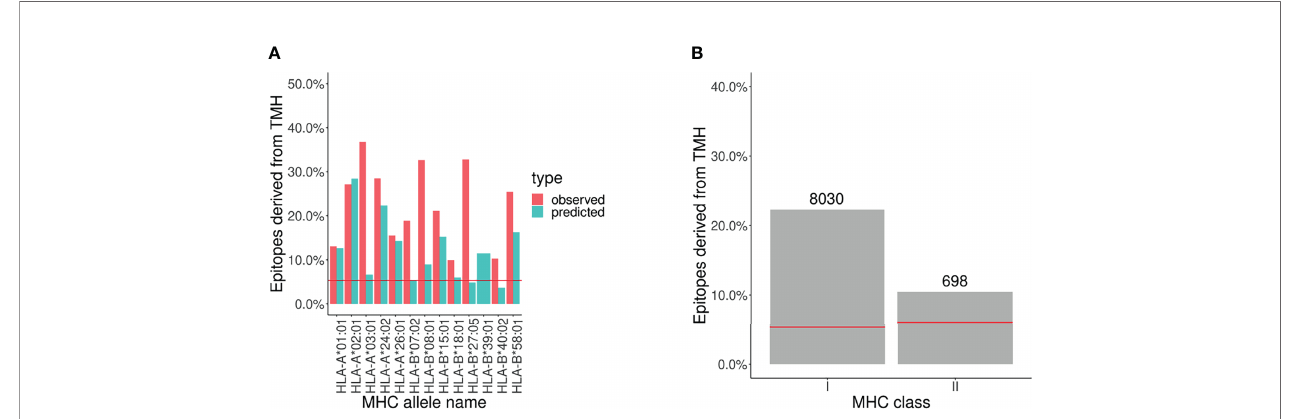
FIGURE 2 | Analysis of epitope database shows that TMH derived epitopes are over-presented. The percentage of epitopes for MHC-I and -II alleles that overlap with TMHs that are presented. The pair of horizontal red lines in each plot indicate the lower and upper bound of the 99% con fi dence interval. Note that only one line is visible as this interval is relatively narrow. Alleles are listed in Supplementary Table S8 . (A) Observed and predicted percentage of TMH-derived epitopes for MHC-I alleles. (B) MHC ligands from IEDB corresponding to TMH-derived epitopes. The numbers above the bars denotes the number of TMH derived epitopes